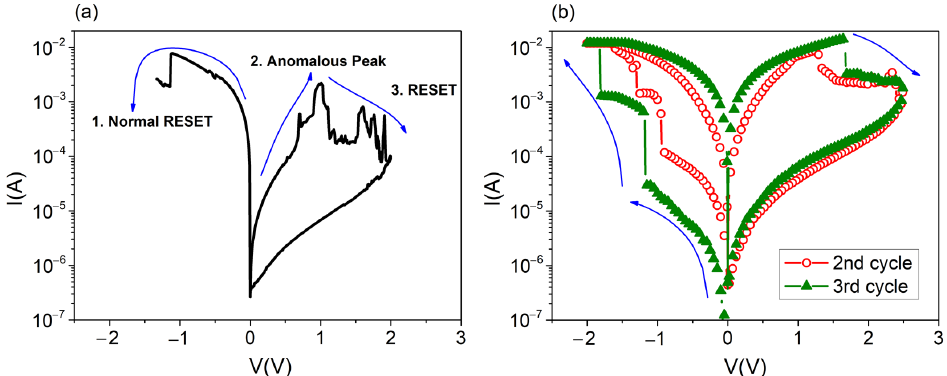
Figure 5. Resistive switching behaviour of the 13 nm film after a positive electroforming process. ( a ) 1st cycle after the electroforming. A negative voltage was applied to trigger the RESET event and confirm that the polarity had inverted (step 1). However, the device presented an anomalous peak resembling a failed SET event (step 2) after which a RESET occurs (step 3). ( b ) Two subsequent cycles, the sample still demonstrates CW RS.